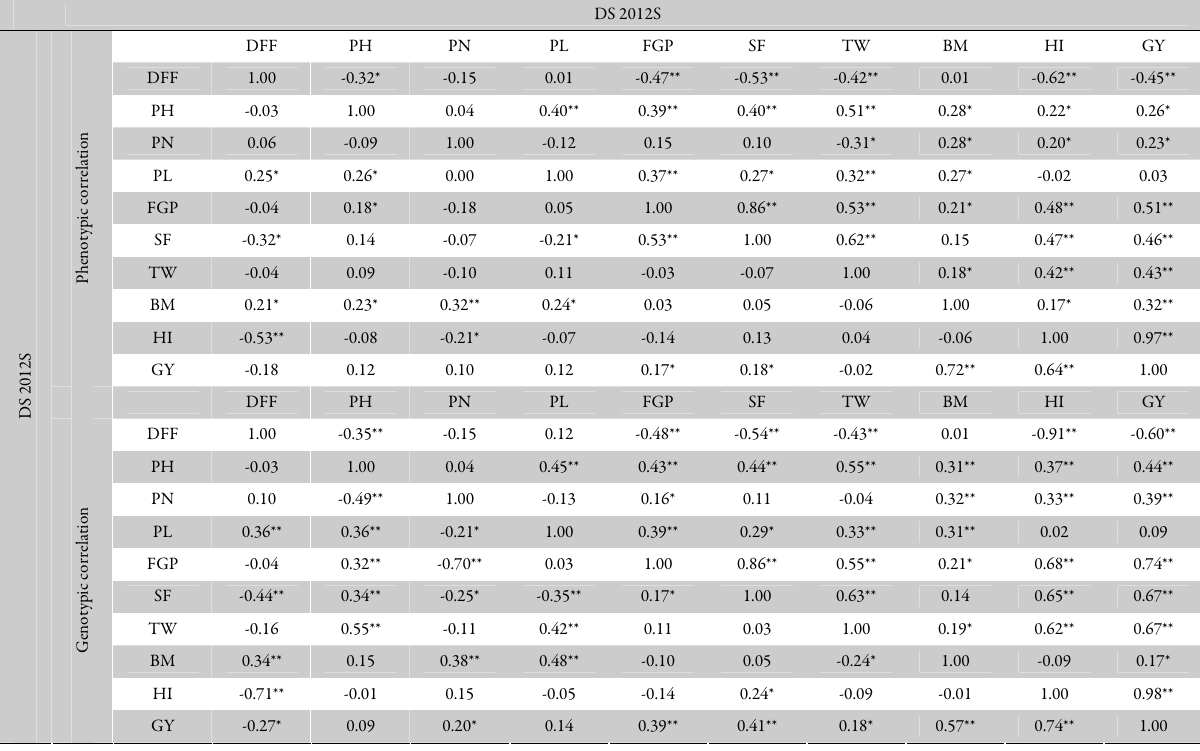
Tab. 3c. Phenotypic and genotypic correlation coefficients between yield and yield components traits of the Swarna/WAB450-I-B-P-157-2-1 population under reproductive stage stress (S) (above the diagonal) and control (C) (below the diagonal) conditions in DS 2012